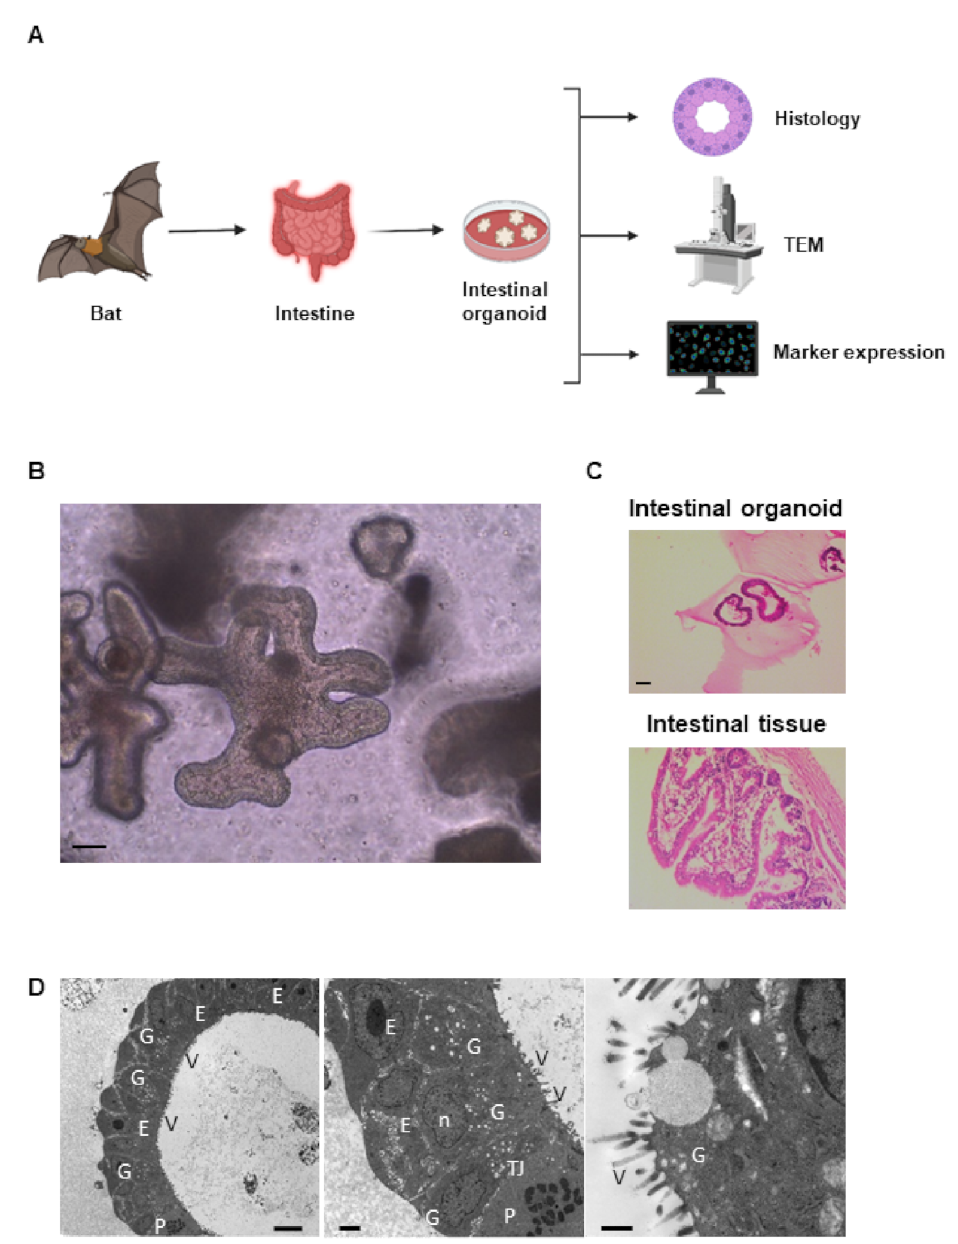
Figure 1. Generation of primary rousette bat intestinal organoids. Experimental schema of establish- ment and analysis of Rousette bat intestinal organoids ( A ). Bat intestinal tissues were isolated and cultured for generating their organoids. Then, each tissue-derived organoid was used for the analysis of histology, microstructure by transmission electron microscopy (TEM), and marker expression. Representative phase-contrast images of the organoids (passage 8 at day 10). Scale bar: 200 µ m ( B ). Hematoxylin and eosin-stained bat organoids and original tissues. Scale bar: 100 µ m ( C ). TEM photomicrographs of organoids ( D ). The absorptive epithelial cells (E), nucleus (n), microvilli (V), tight junction (TJ), goblet cells (G), and Paneth cells (P) are shown. Scale bar: 8 µ m, 2 µ m, 600 nm from left to right panel,